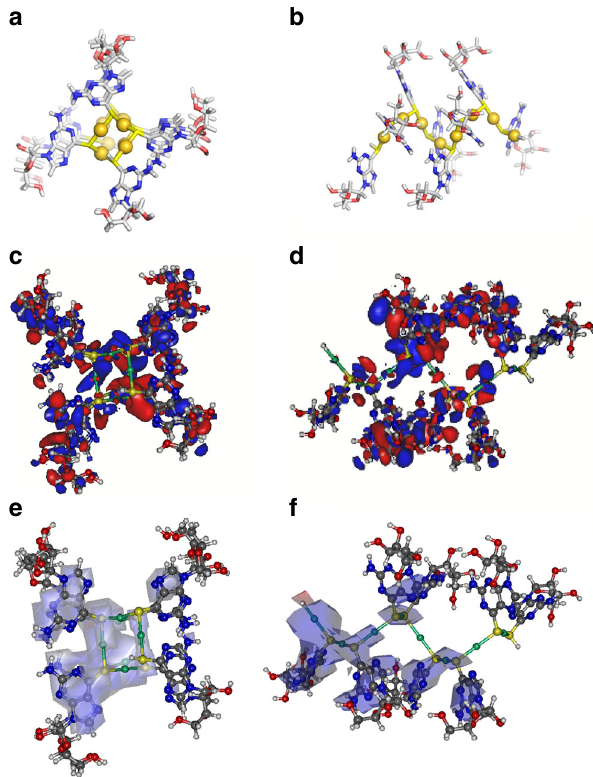
Fig. 2 A model of the coordination polymer chain of {Au(I)-thioguanosine} n viewed along and onto the helical chain axis. a , b Single point energy DFT calculations for an oligomer (Au 8 6TG 8 ) using the SBKJC effective core potential and basis set with the B3LYP functional. The helical conformation shown is based on the geometry of comparable Au-thiolates determined by XRD. c View of the HOMO looking along the axis of the helix; d The HOMO from a direction normal to the helical axis; e Spin density map for the singly-charged radical cation (Au 8 6TG 8 ) + . Looking along the helical axis and f the spin density map from a direction normal to the helical